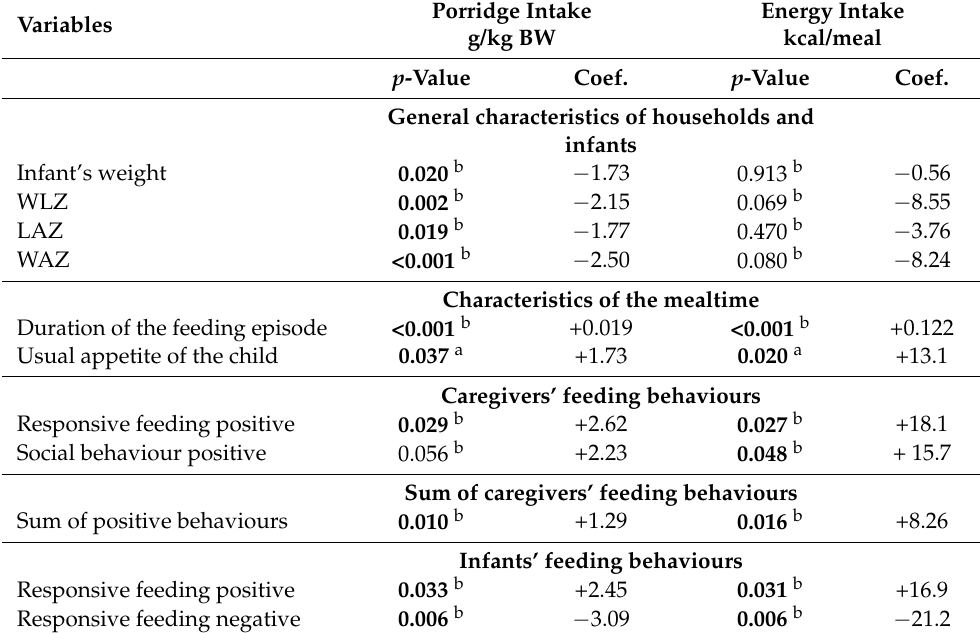
Table 5. Variables significantly associated with the children’s porridge and energy intake: univariate